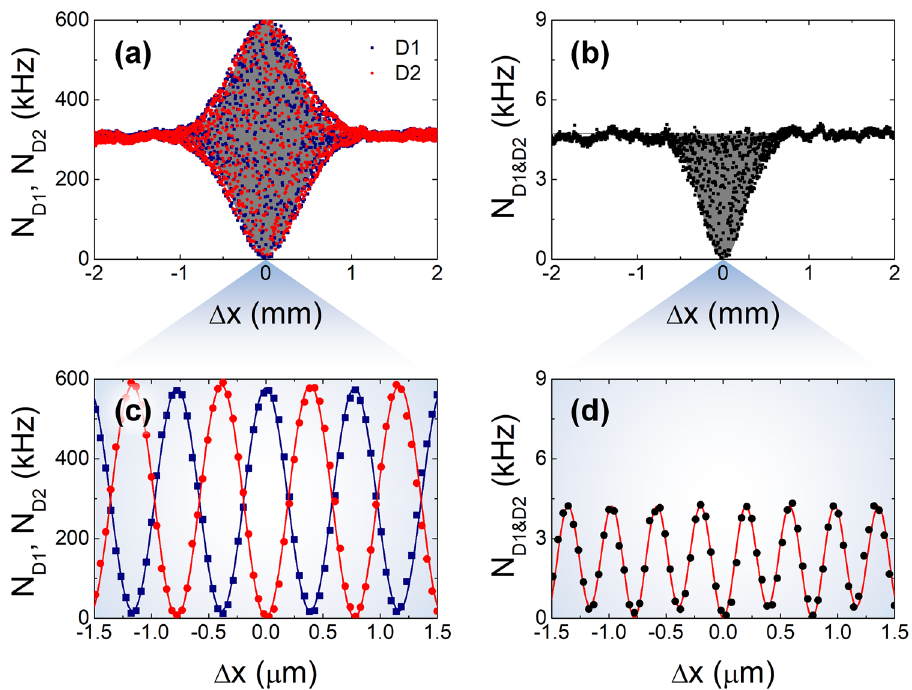
Figure 5. One- and two-photon interference fringes of weak coherent pulses. ( a ) Single ( N D1 , N D2 )- and ( b ) coincidence ( N D1&D2 )-counting rates as functions of path-length difference (cid:31) x (step size of 2 μm). ( c , d ) 0 Interference fringes measured at (cid:31) x ≈